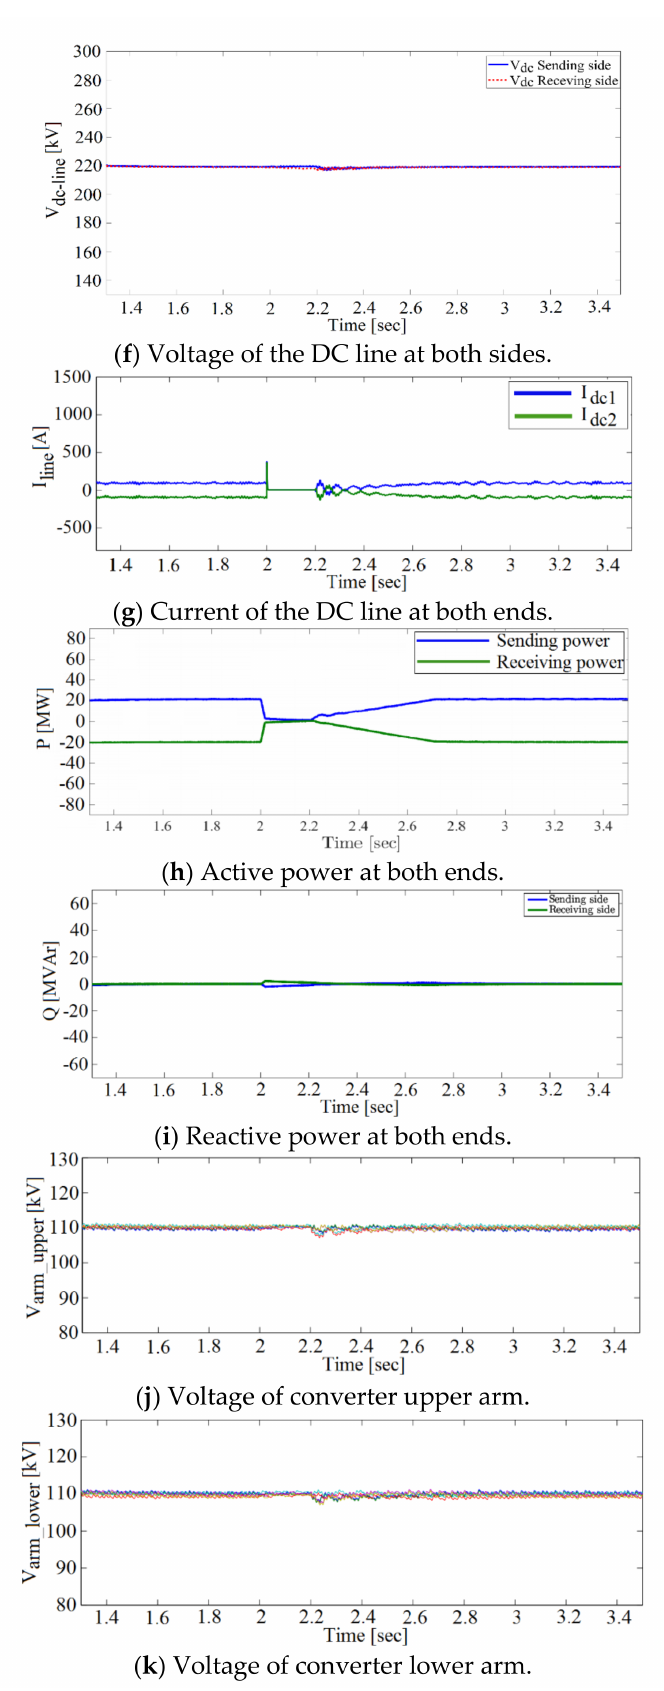
Figure 18. Simulation results of proposed solid-state